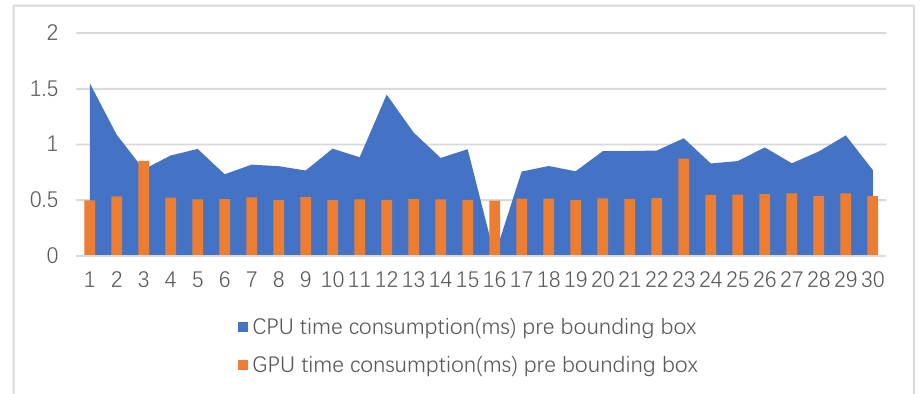
Figure 8. Computational resource consumption of each bounding box.